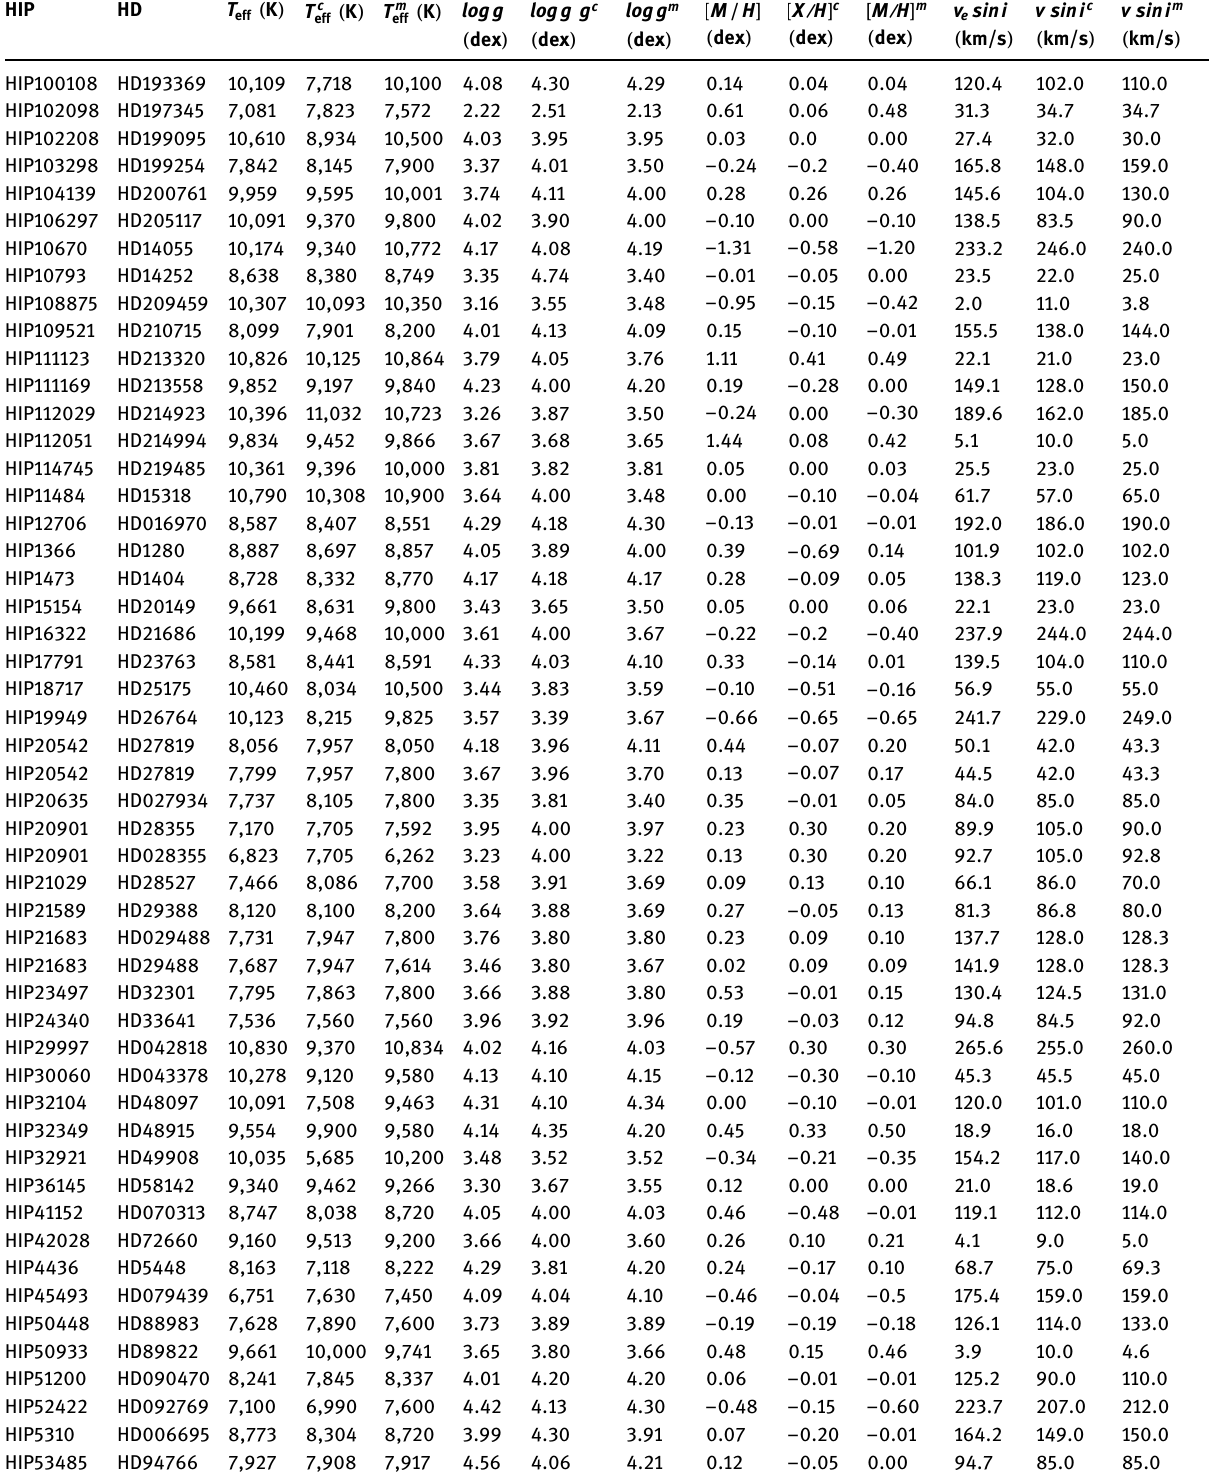
Table A1: Predicted values for T eff